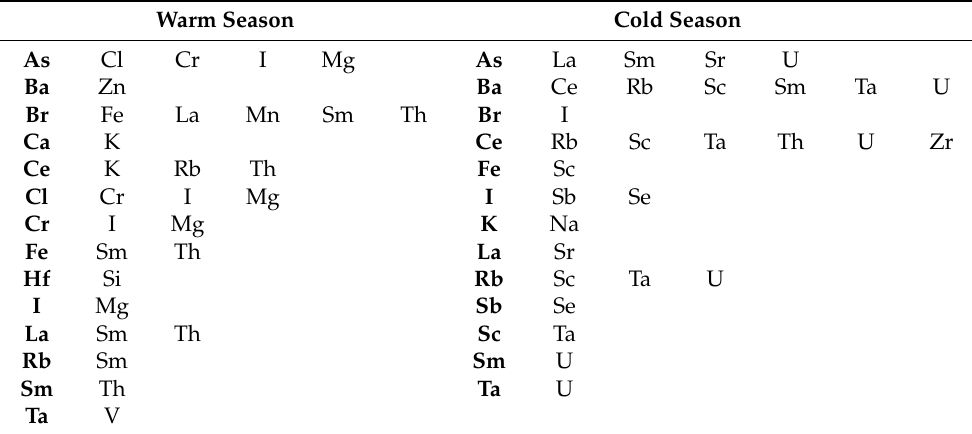
Table 3. Elements with Pearson correlation coefficients >0.7 determined for the respective